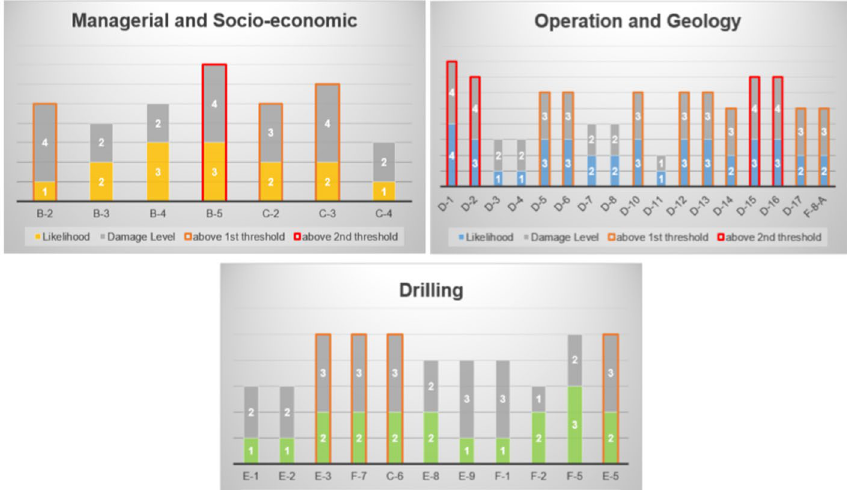
Fig. 6 Graphical representation (bar charts) of the different risks for each category (highlighted in red the unacceptable risk and in amber the moderate risks). The risk ID corresponding description is given Fig.